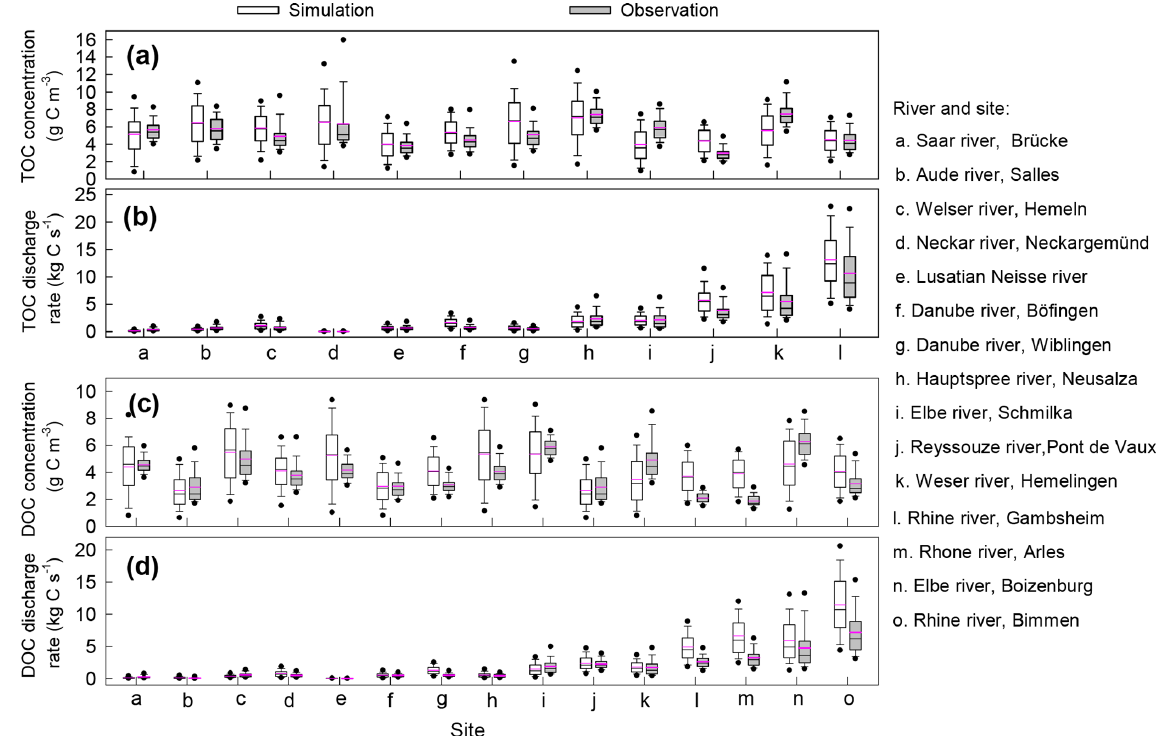
Figure 6. Comparison between the observed and simulated concentrations of total organic carbon (TOC, a ) and dissolved organic carbon (DOC, b ) in river flows, as well as the discharge rates of riverine TOC and DOC. The black and pink lines in each box denote the median and mean value, respectively. Box boundaries show the 25th and 75th percentiles, whiskers denote the 10th and 90th percentiles, and the dots below and above each box denote the 5th and 95th percentiles,